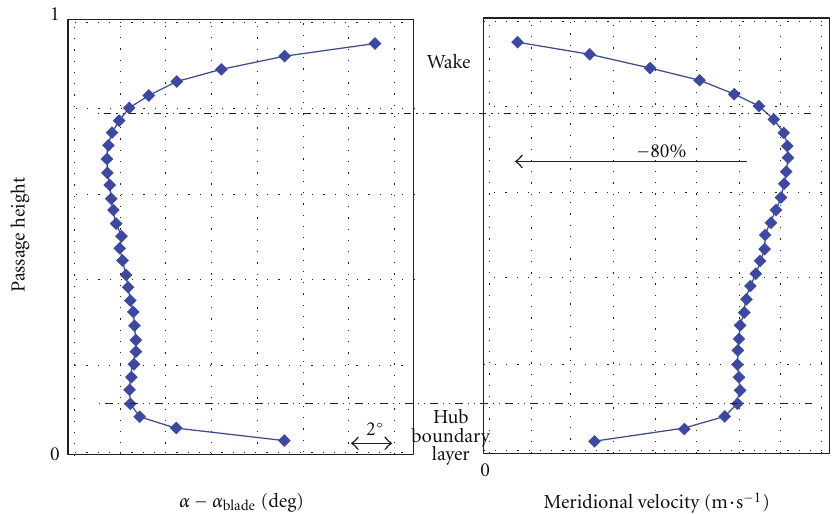
Figure 10: Flow conditions at di ff user inlet operating point B.